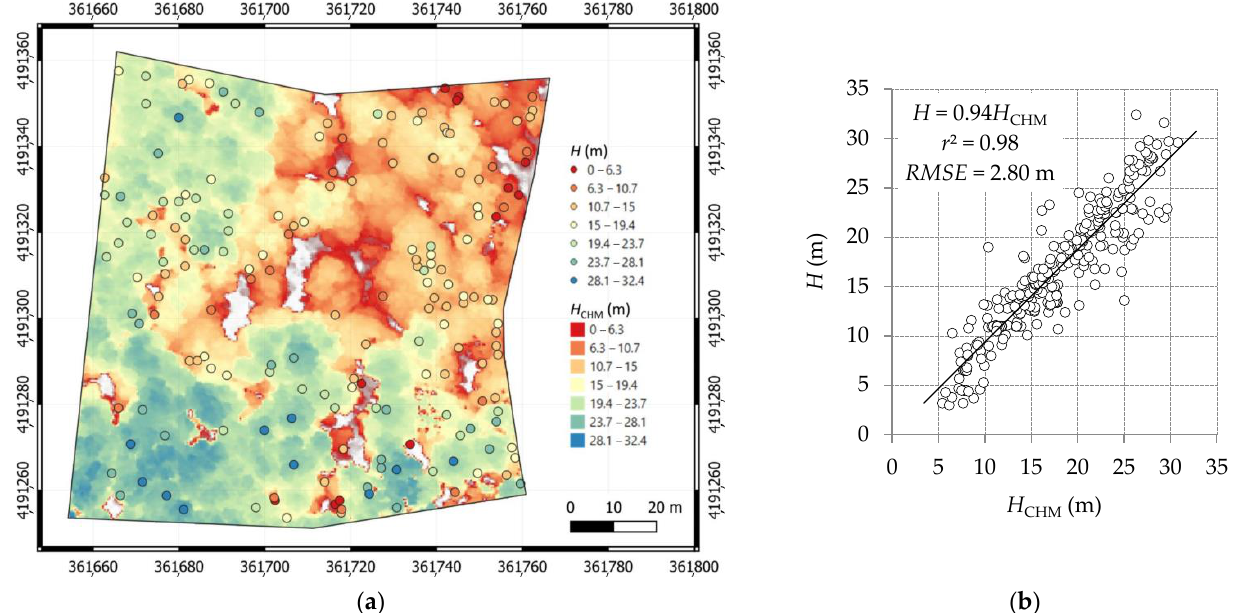
Figure 9. ( a ) Graduated color map of the CHM (equal interval discretization) with over-imposed height of the trees measured in situ (equal interval, same color scale), EPSG: 6706; ( b ) scatterplot between H CHM and H (empty circles) with descriptive statistics (gain, determination coefficient r 2 , and RMSE ) and linear trend line (in black).